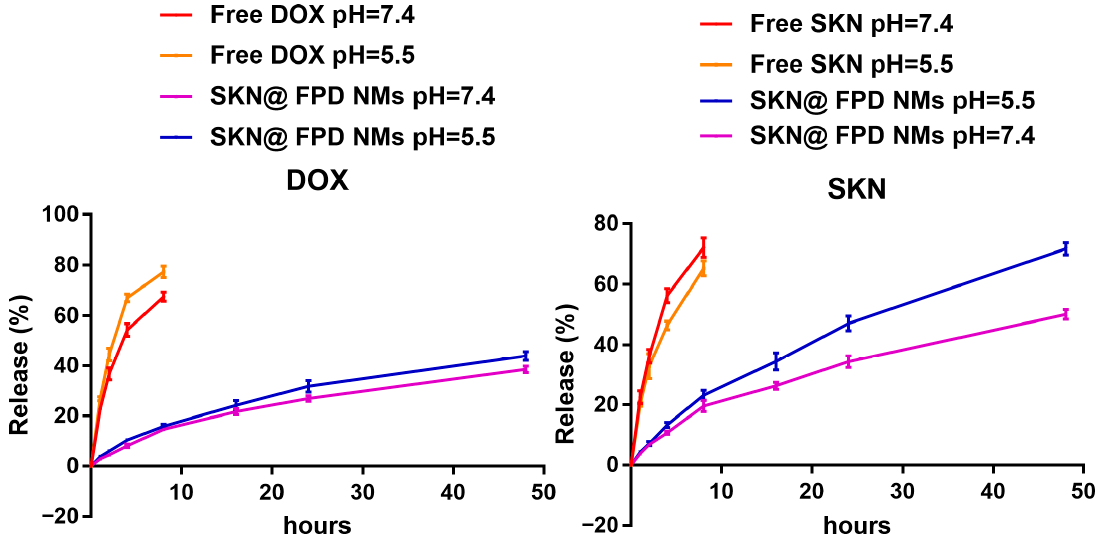
Figure 5. DOX (left) and SKN (right) release of SKN@PPD NPs in PBS (pH = 7.4) and acid PBS (pH = 5.5) over 48 h.